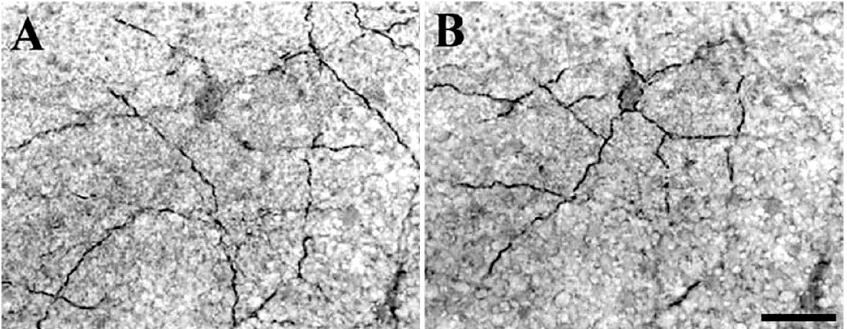
Figure 3. Retinal somatostatinergic interneurons. Photomicrographs of a displaced amacrine cell immunolabelled for somatostatin (avidin-biotin-peroxidase technique) at two depths. Cytoplasmic processes extensively arborize into a meshwork of interwoven varicose fibers at two different levels (A, B) in the IPL. Scale bar, 30 µm. Modified from [68].